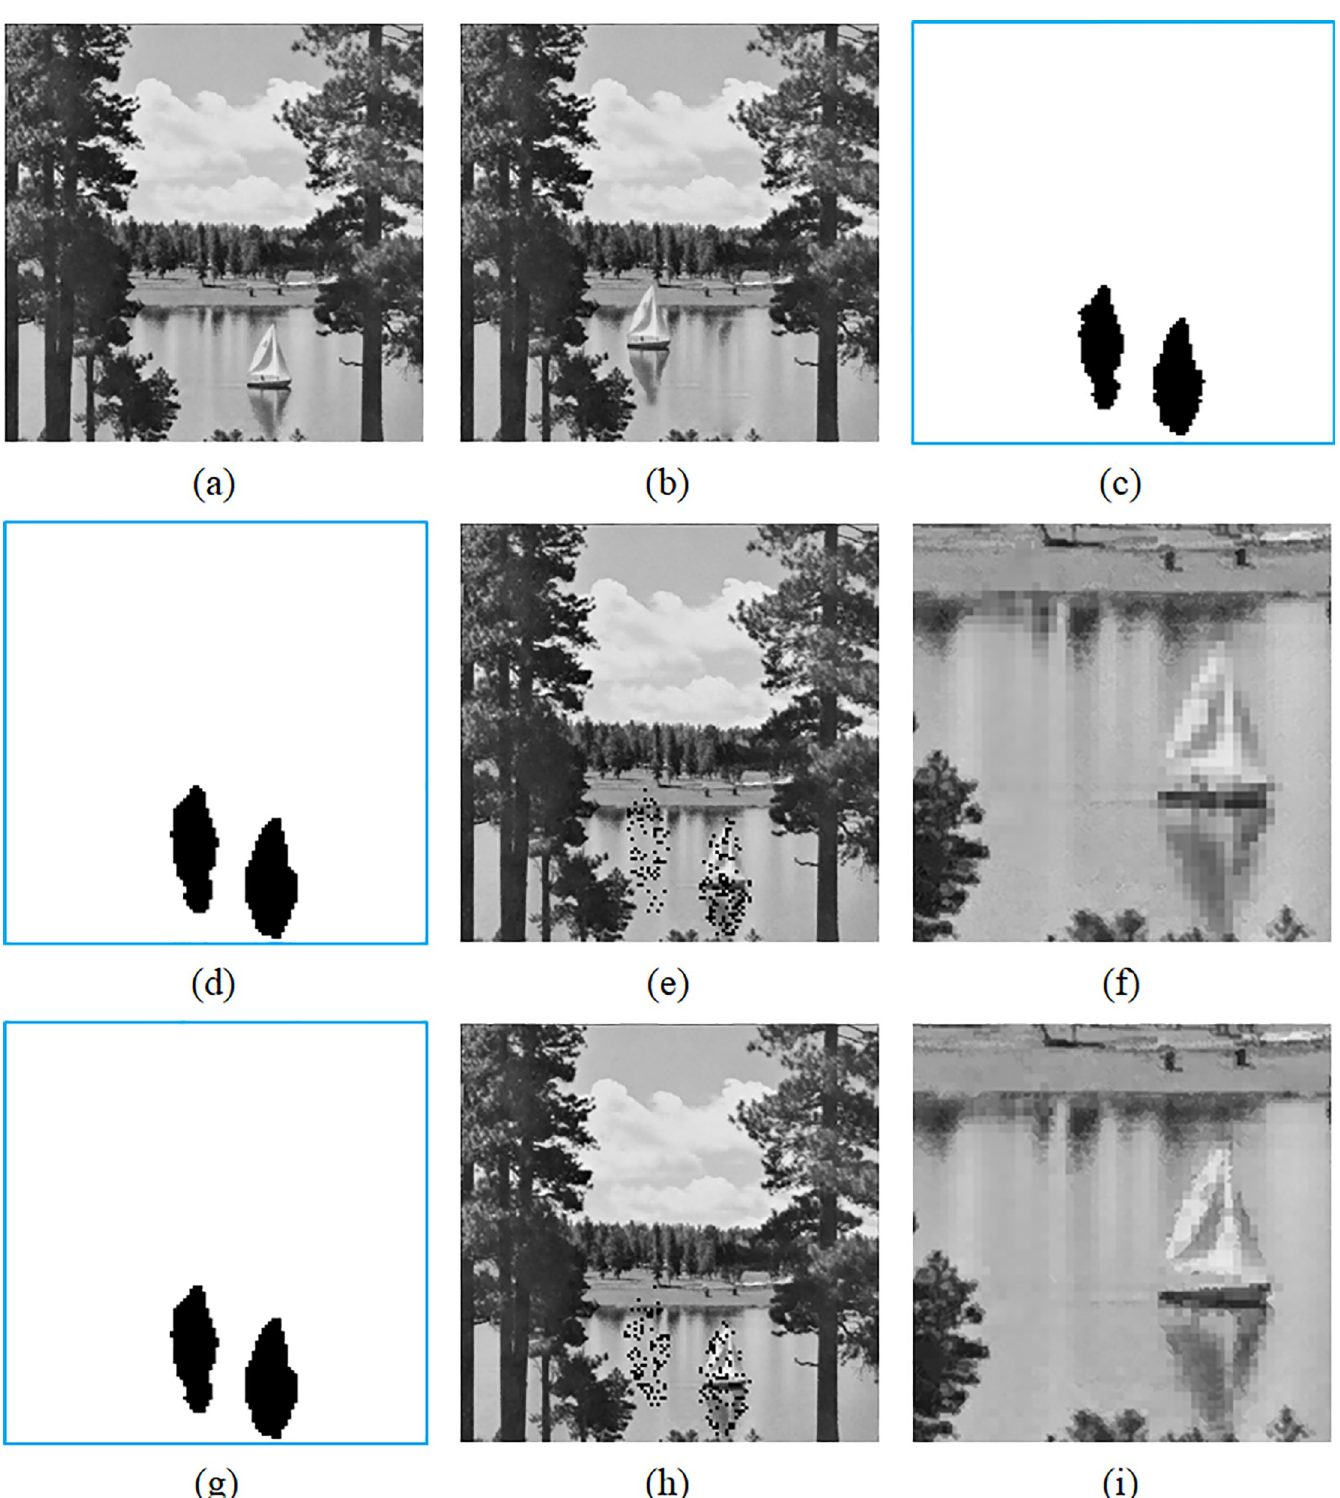
Fig 7. Comparisons of the detection and recovery results. (a) Marked image. (b) Tampered image. (c) Tampered regions. (d) Second-stage detection of Hu et al.’s method. (e) First-stage recovery of Hu et al.’s method. (f) Second-stage recovery of Hu et al.’s method. (g) Second-stage detection of the proposed method. (h) First-stage recovery of the proposed method. (i) Second-stage recovery of the proposed method.